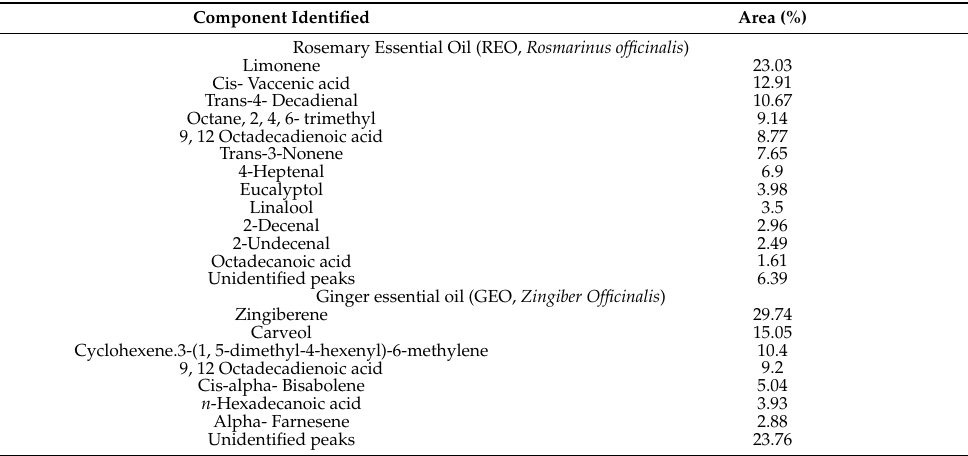
Table 2. List of the active components profile of rosemary and ginger essential